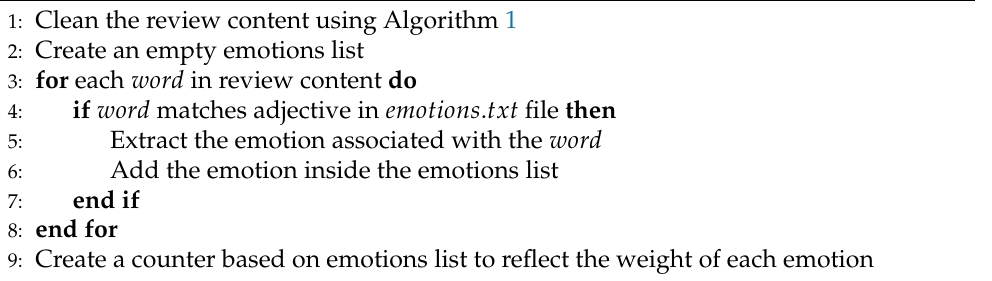
Algorithm 2 Algorithm for extracting the emotions present in a review.